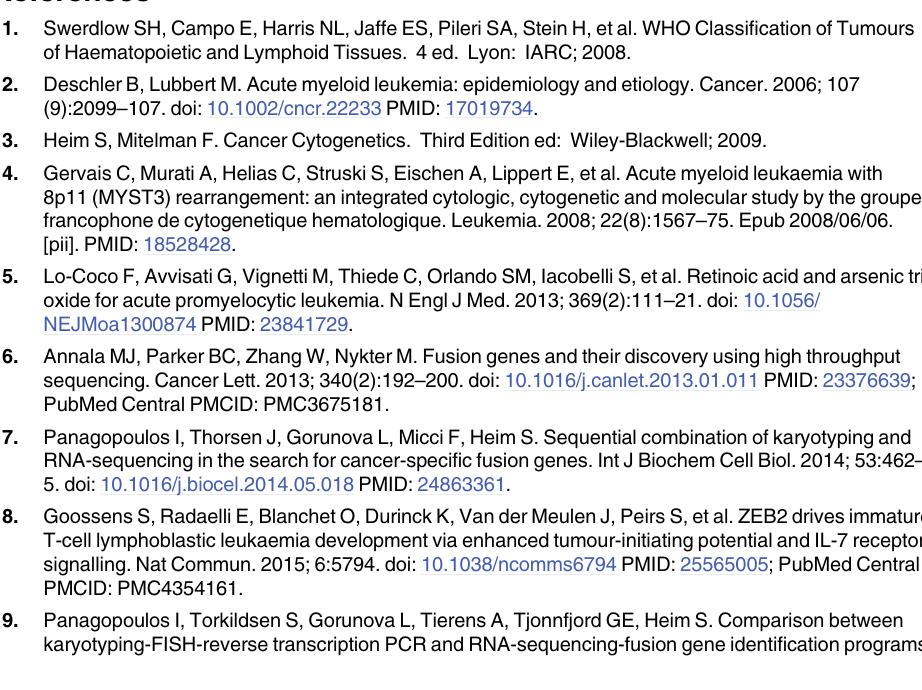
S1 Table. Fusion transcripts identified using FusionCatcher. Fusion transcripts detected using FusionCatcher. S2 Table. Fusion transcripts identified using ChimeraScan. Fusion transcripts detected using